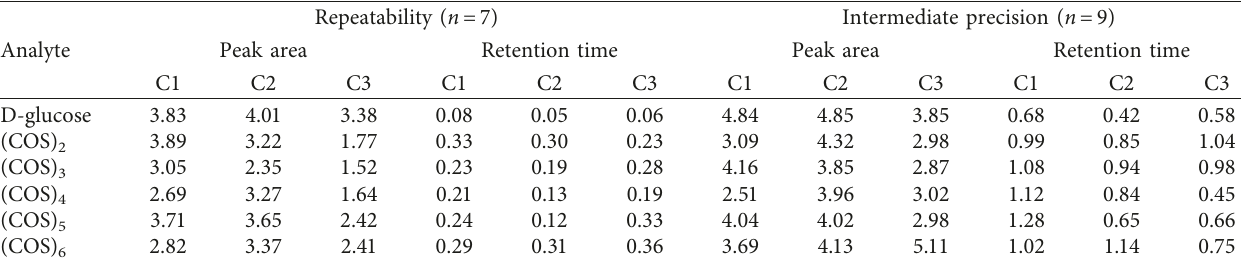
Table 4: Determination of method precision under repeatability (intraday) and intermediate precision (interday) conditions given as RSD (%) of peak area and retention time.